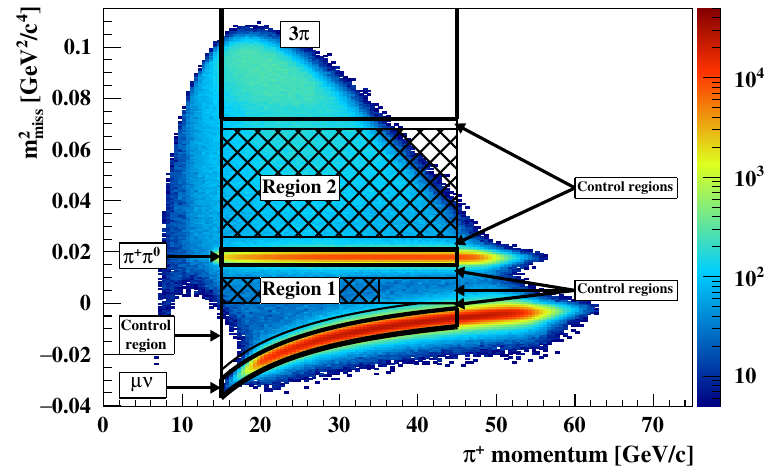
as a function of p for minimum-bias events selected without Figure 2 . Reconstructed m 2 π + miss applying π + identification and photon rejection, assuming the K + and π + mass for the parent and decay particle, respectively. Signal regions 1 and 2 (hatched areas), as well as 3 π , π + π 0 , and µν background regions (solid thick contours) are shown. The control regions are located between the signal and background